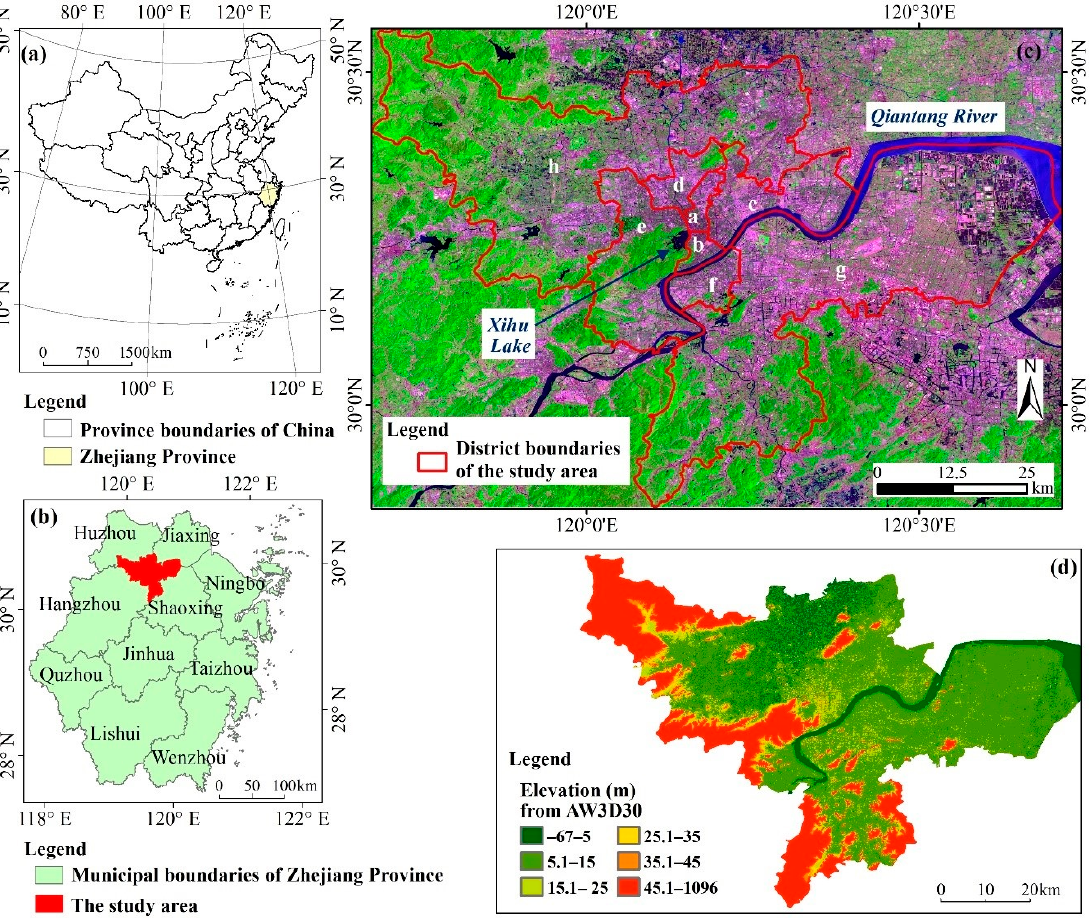
Figure 1. The location ( a , b ) and mosaic image ( c ) of the Landsat-8 OLI from May to October of 2020, and the elevation ( d ) from the Advanced Land Observing Satellite World 3D-30m (AW3D30) of the study area. Here, a, b, c, d, e, f, g, and h represent Shangcheng, Xiacheng, Jianggan, Gongshu, Xihu, Binjiang, Xiaoshan, and Yuhang districts, respectively. The mosaic image is displayed as RGB = Band 7 (short wave infrared-2), 5 (near-infrared), and 4 (red) to highlight the impervious